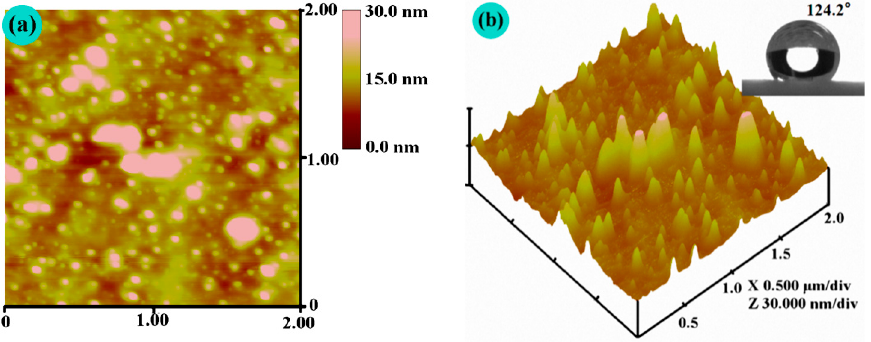
Figure 5. AFM diagram of PFAS-SiO 2 -3: ( a ) height image; ( b ) three-dimensional image.